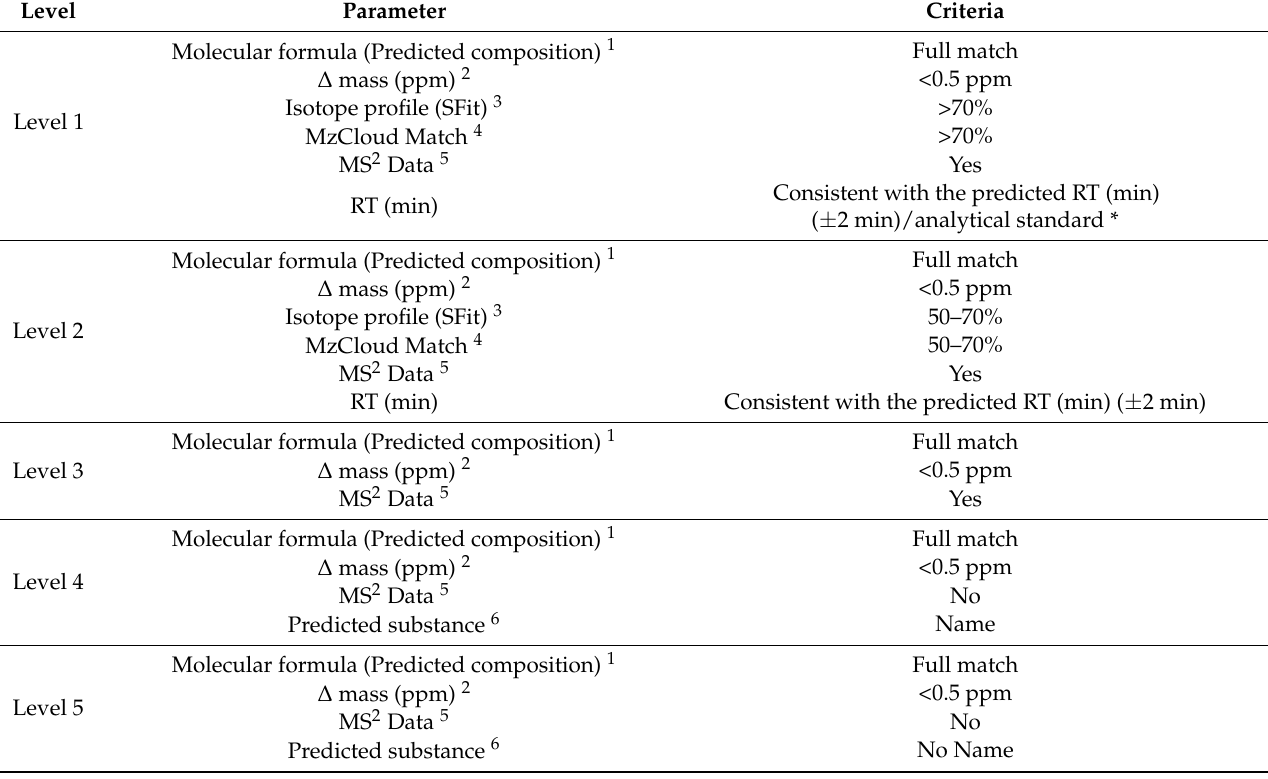
Table 2. Levels of confidence and criteria used for tentative